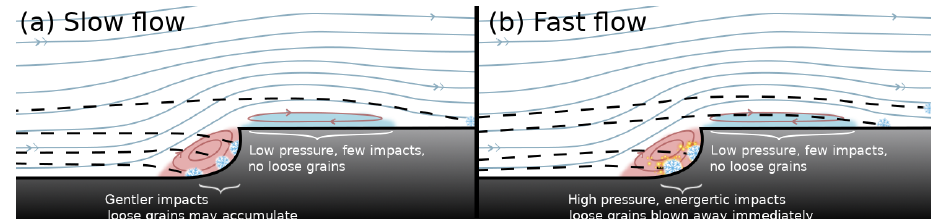
Figure 15. Conceptual model for air and particle flow over a snow step in (a) slow-moving and (b) fast-moving air. Solid lines show idealized streamlines over the step, including two regions of detached flow (shaded in panel a ). Dashed black lines show snowflake